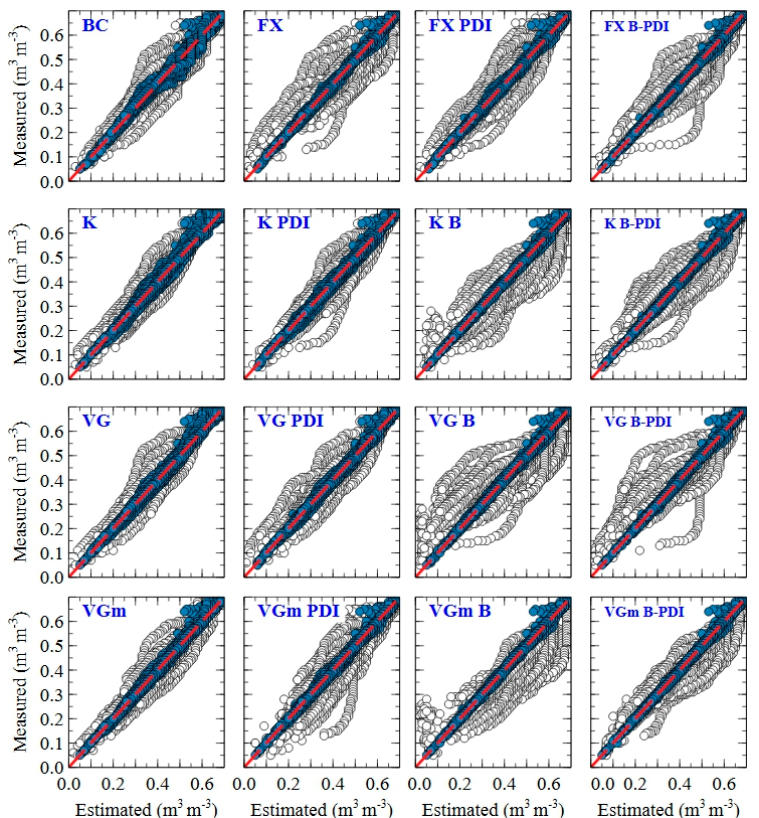
Figure 3. Scatter plots of the fitted (dark blue) and the PTF-estimated (white) versus the measured soil water content data (scenario 6). 1 BC: Brooks and Corey [34], FX: Fredlund and Xing [35], K: Kosugi [36], VG and VGm: van Genuchten [24] constrained and unconstrained unimodal models. PDI